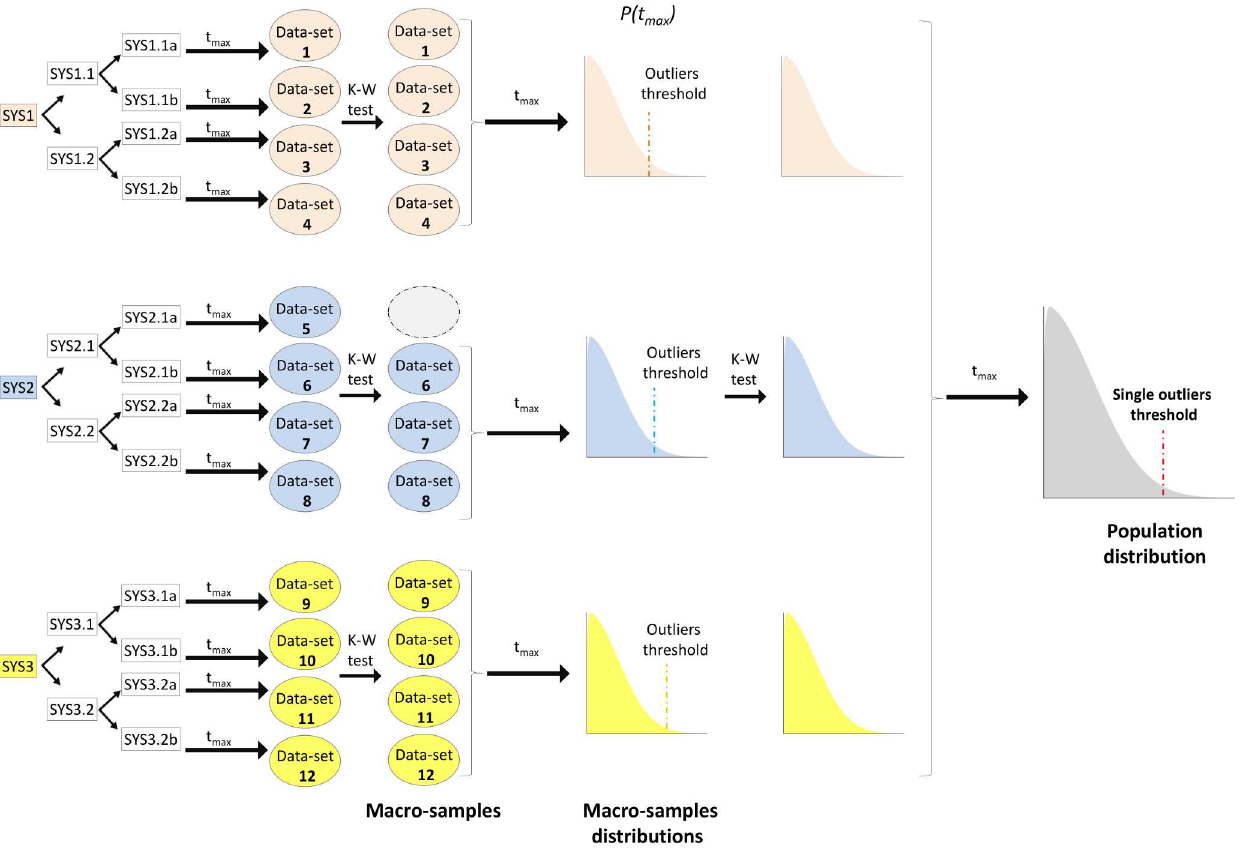
Fig 1. Schematic picture of data processing and statistical analysis carried out on SYS1-3. Data-sets, macro-samples and population distributionsare shownand colored accordingly to each system (K-W: Kruskall-Wallis). For sake of clarity, the assessment of sampling convergence involvinga third copy of SYS3 (SYS3.3) is not